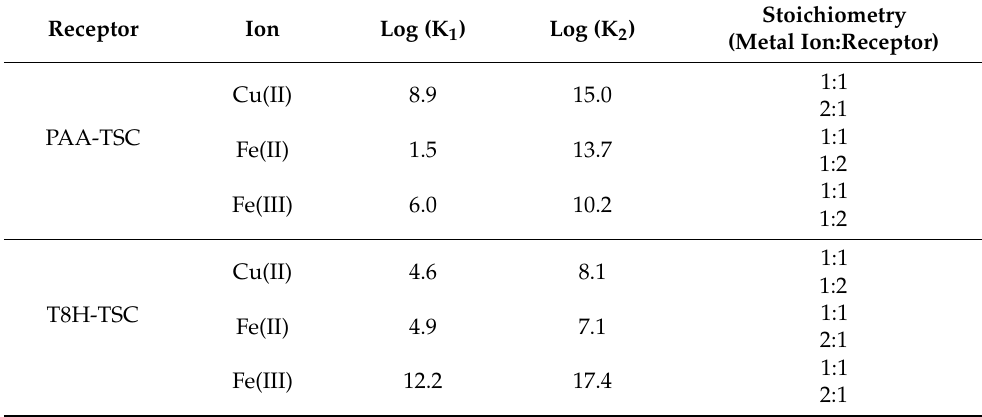
Table 2. Ka values and stoichiometry of receptors (PAA-TSC, T8H-TSC) in complex with metals (Cu(II), Fe(III), Fe(II)) in water (water/DMSO, 99:1, v / v ).